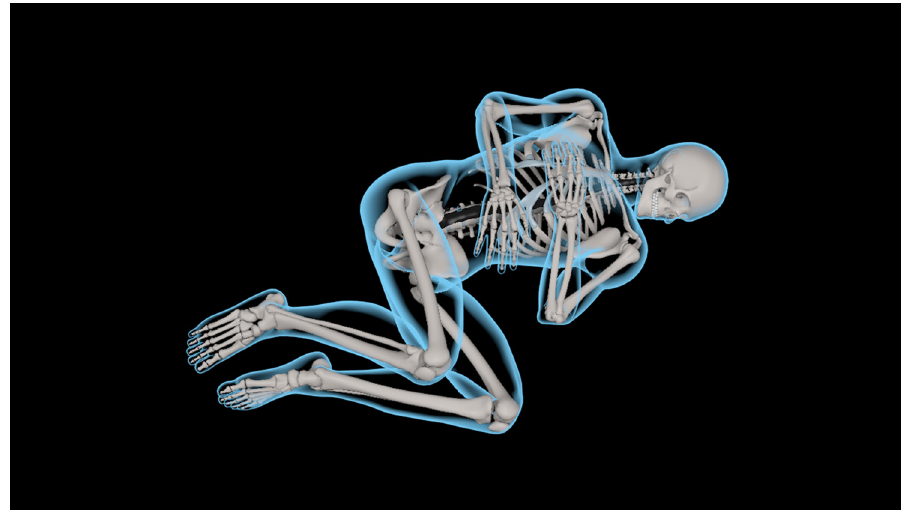
Figure 5: Motioncow digital anatomical reference model ( posed )